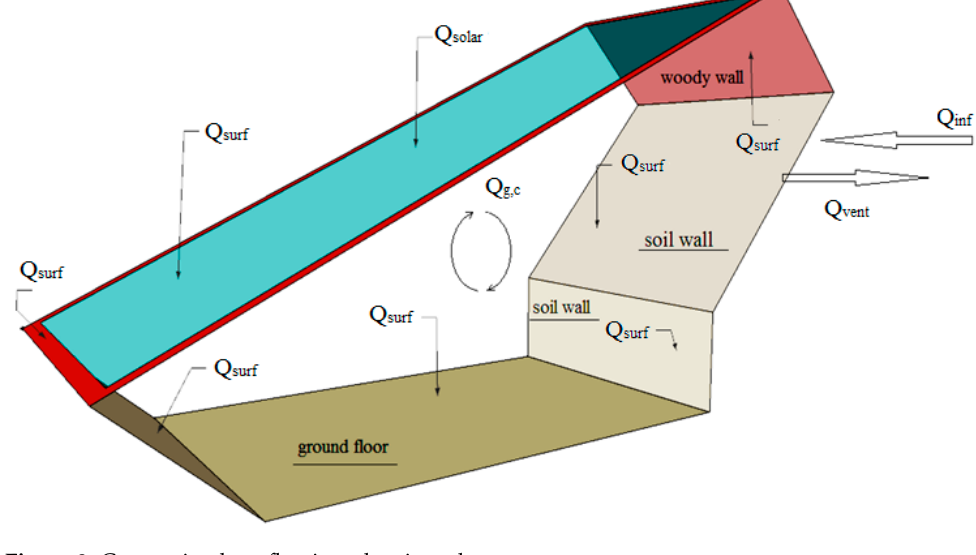
Figure 3. Convection heat flux into the air node.